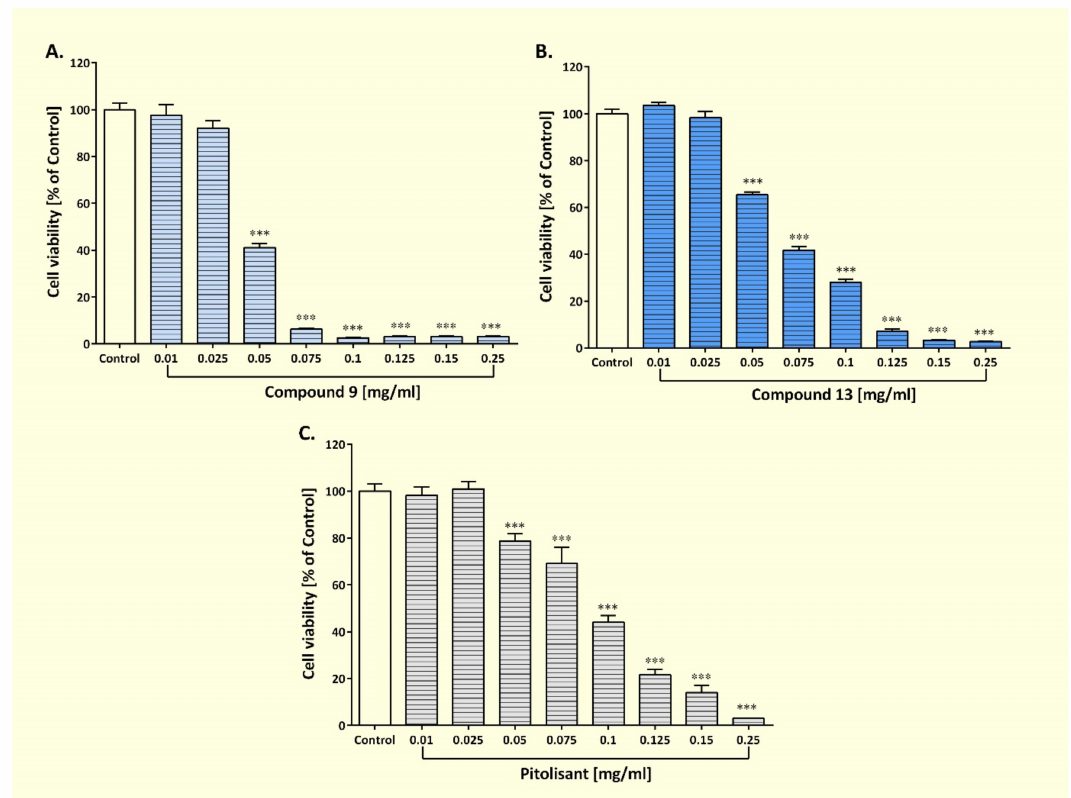
Figure 6. The effects of compound 9 ( A ), 13 ( B ) and pitolisant ( C ) on the viability of human astrocytes after 24 h of incubation. Bars represent the means ± SEM of 6 experiments and expressed as percentage of untreated control cells. One-way ANOVA and Dunnett’s multiple comparisons test: *** p < 0.001 vs. corresponding control (untreated